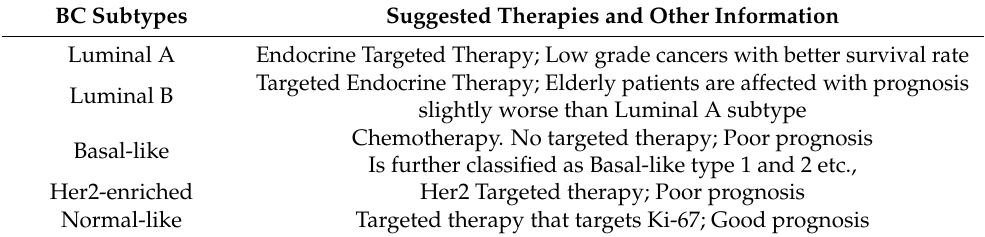
Table 1. PAM50 BC subtype